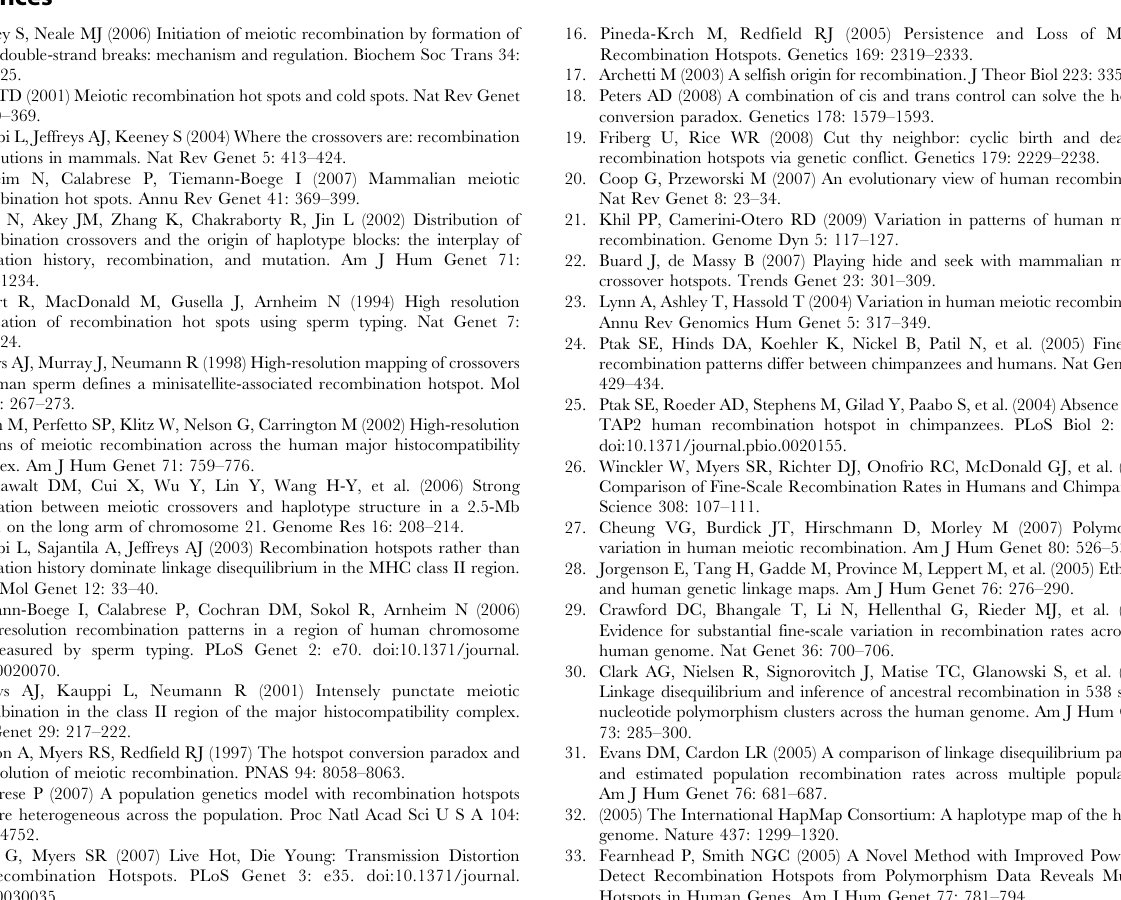
Table S2 Summary of the crossover detection simulation. Table S3 Percentages of genetic and physical map found inside hotspots for each of the four population samples. Table S4 Summary of CEU bins. Table S5 Summary of Adjustment